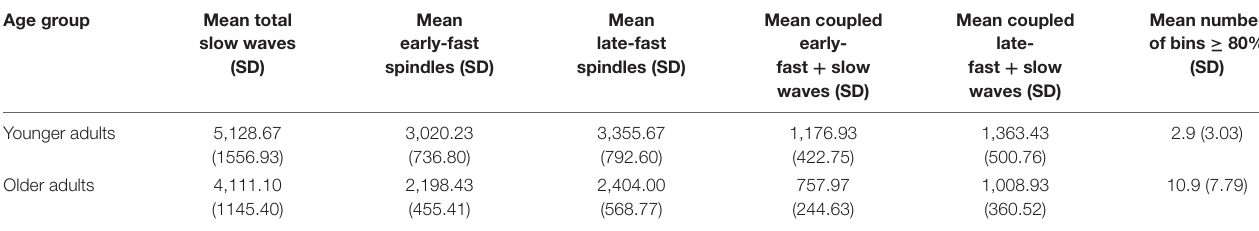
TABLE 4 | Slow wave and spindle event counts, and mean number of bins exceeding a threshold of 80% composition of the late-fast subtype, for younger and older adults from the Cleveland family study. Age